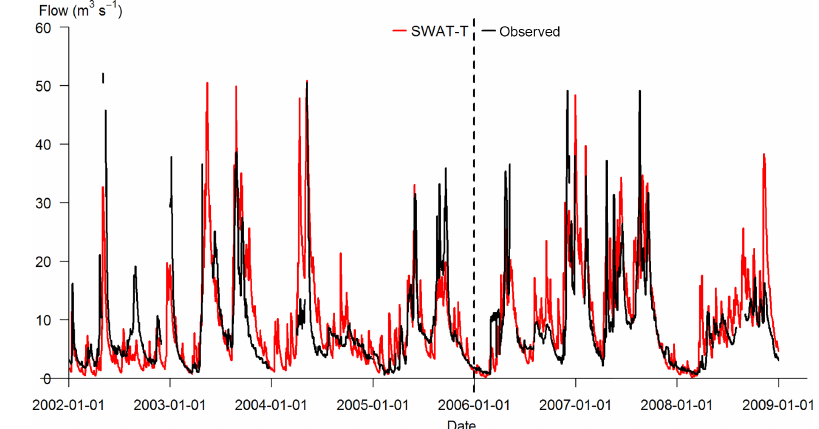
Figure 13. Observed and simulated flows for the Nyangores River at